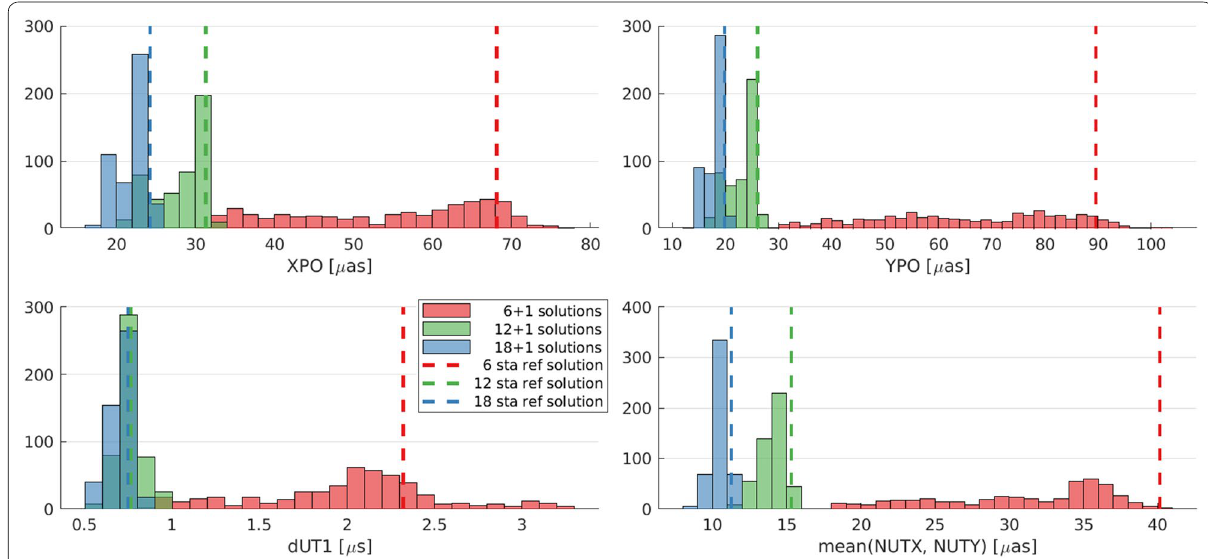
Fig. 6 Histogram over the expected repeatability values visualized in Figs. 3, 4, and 5. The dashed vertical line indicates the simulated EOP repeatabilities of the fixed networks without an additional variable antenna